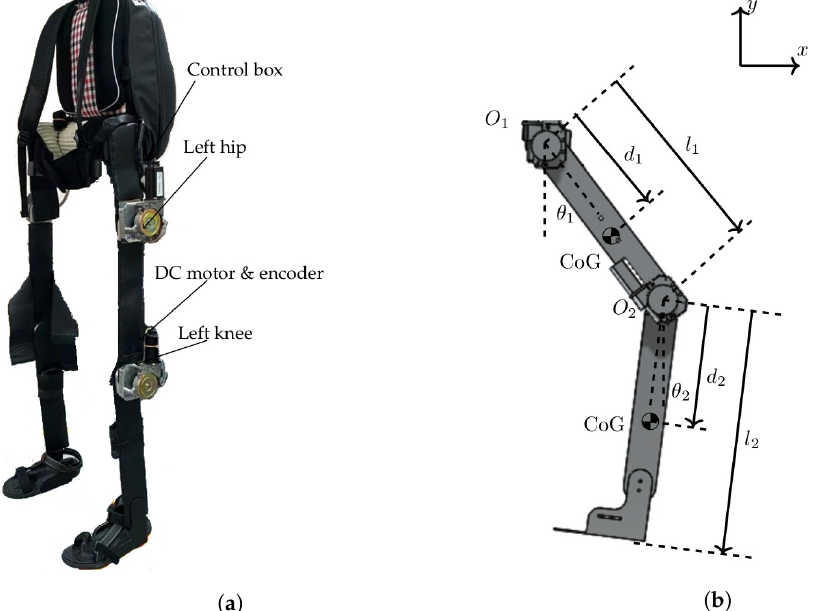
Figure 1. Structure and kinematic diagram of LLAR: ( a ) components of LLAR, ( b ) kinematic diagram. Each joint is operated by a 12 V brushed DC motor and a worm gearbox. The generated torque is transmitted to the worm gearbox with gear ratio of 32. A quadrature encoder is located at the motor shaft to record the angle of each joint with a resolution of 200 pulses per rotation. An Arduino Mega 2560 is used to control and capture the data from the encoder and regulate the input voltage and direction of actuators based on the determined data from the control system. Figure 2 illustrates the structure of hardware of the LLAR.